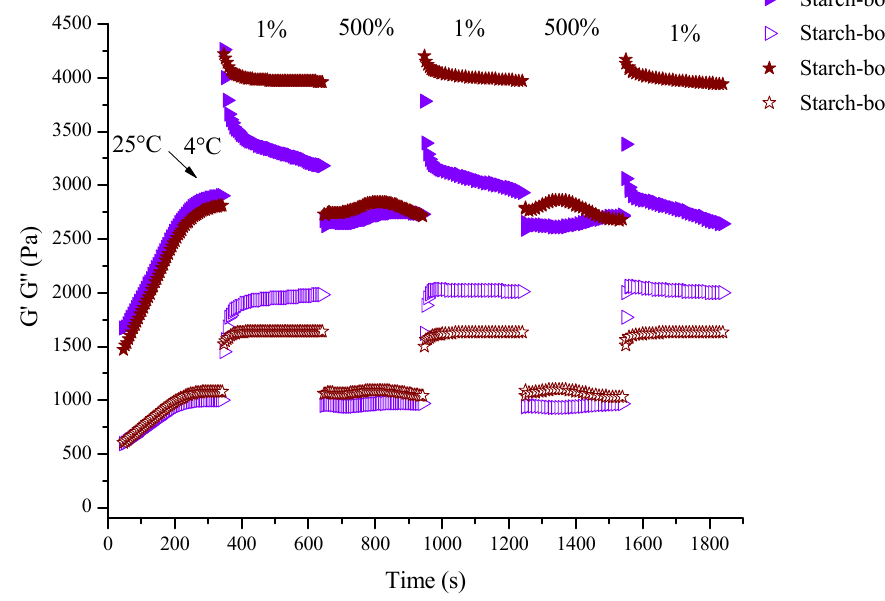
Figure 4. The G ′ and G ″ of the starch–borax DC hydrogels with different content levels of borax, when alternate step strain switched from small strain ( γ = 1%) to large strain ( γ = 500%) at a fixed frequency (1 Hz). Each strain interval was kept for 5 min.